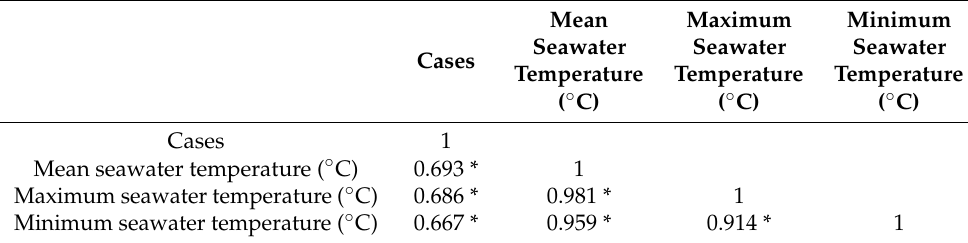
Table 3. Correlation between seawater temperature indicators and V. vulnificus cases.